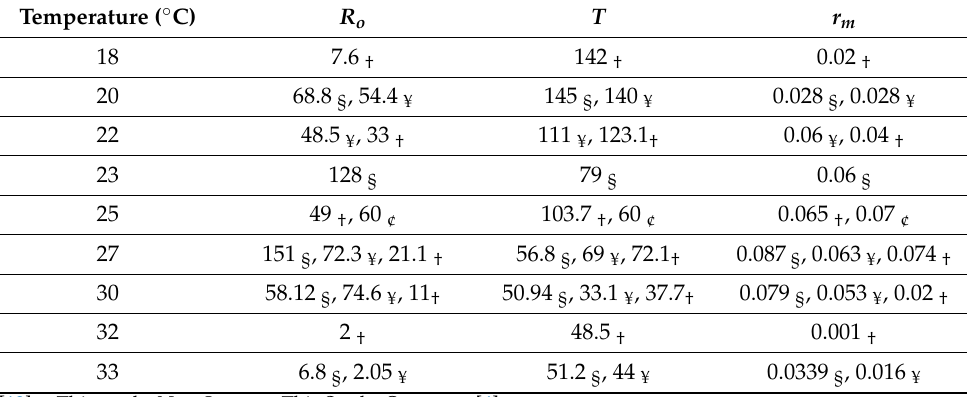
Table 3. Estimated life table parameters in relation to temperature ( ◦ C) of Halyomorpha halys ( R 0 = net reproductive rate; T = mean generation times in days; and r m = intrinsic rate of population increase) from four comparable studies.